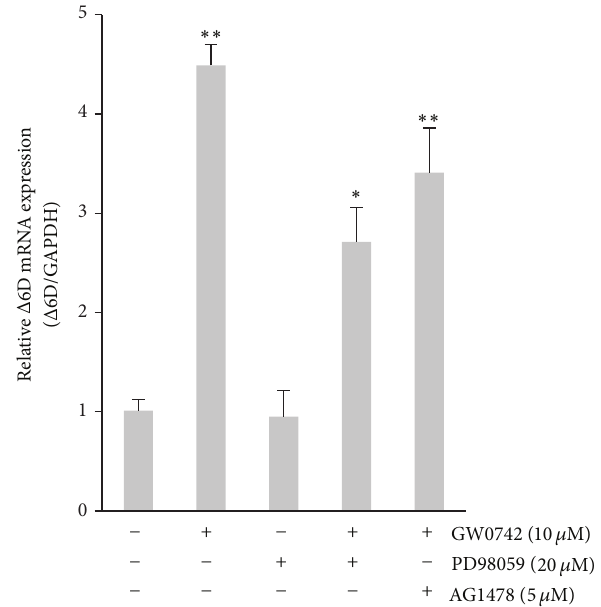
00.511.522.5 − − − Figure 3: Effects of the PPAR 𝛿 agonist, selective inhibitor of MEK/ERK1/2, and EGF receptor-selective tyrosine kinase inhibitor on protein expression of Δ 6-desaturase ( Δ 6D) in PANC-1 human pancreatic tumor cells. Cells were treated with GW0742, PD98059, or AG1478 as indicated. Cell lysates were analyzed for Δ 6 desaturase and 𝛽 -actin. Molecular weight markers are shown. Δ 6 desaturase levels were detected by Western blots, quantified, normalized to 𝛽 - actin, and represented as mean ± SE from 3 independent exper- iments. ∗ and ∗∗ : 𝑃 < 0.05 and 𝑃 < 0.01 for Student’s 𝑡 -test,